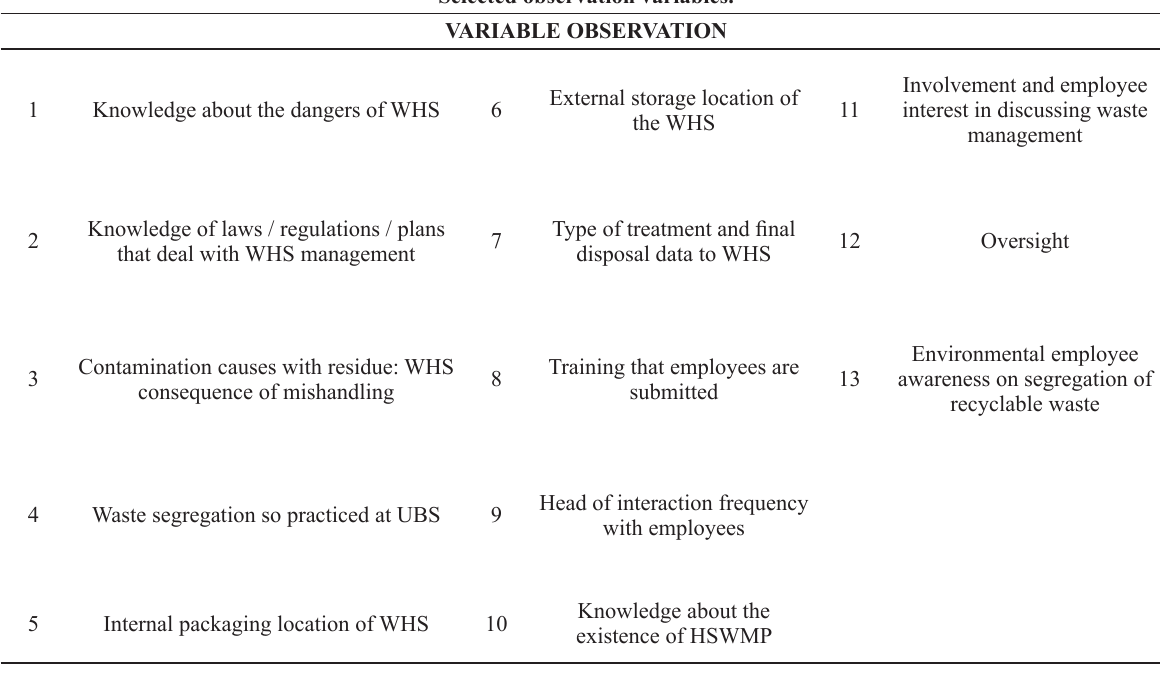
Selected observation variables.